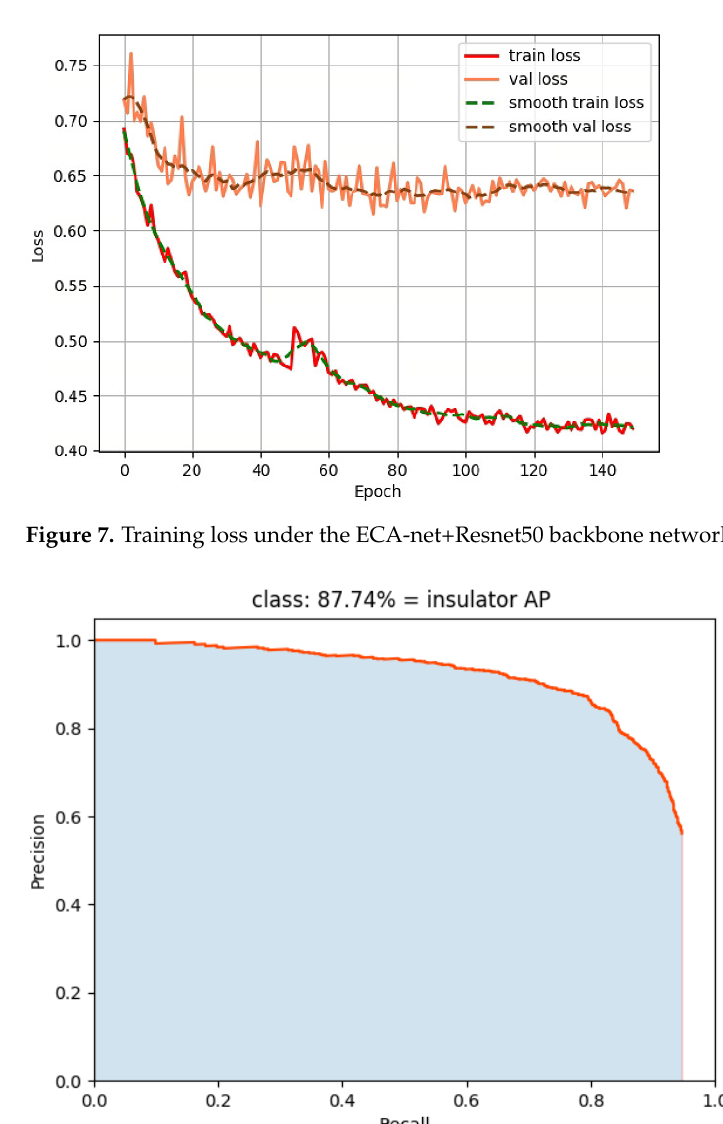
Figure 6. Training loss under the Resnet50 backbone network.